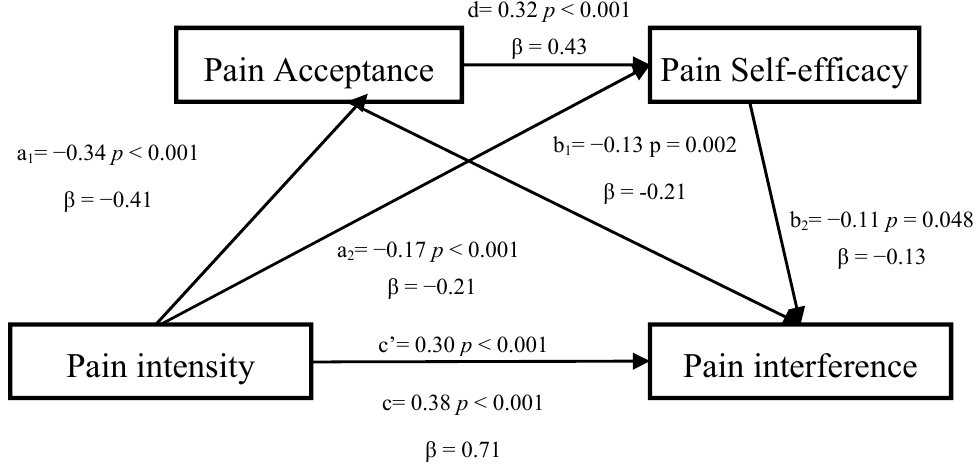
Figure 3. Linear regression results for the multiple mediation model, adjusted by age and gender, with pain acceptance and pain self-efficacy as the mediators between pain intensity and pain interference.